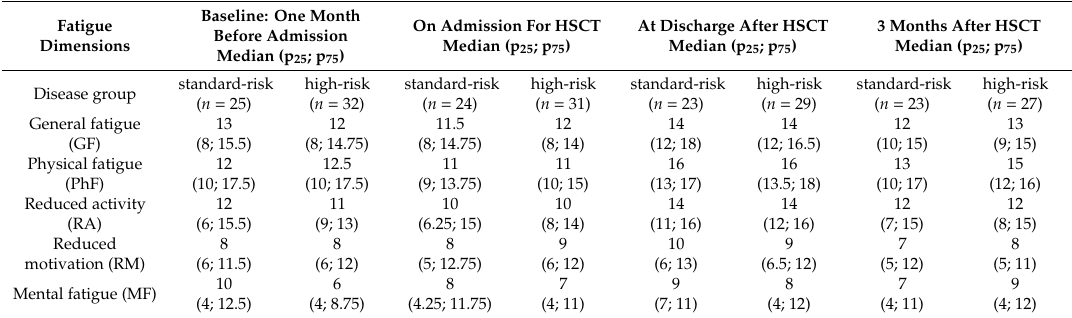
Table 4. The trajectory of fatigue levels related to disease status among patients undergoing